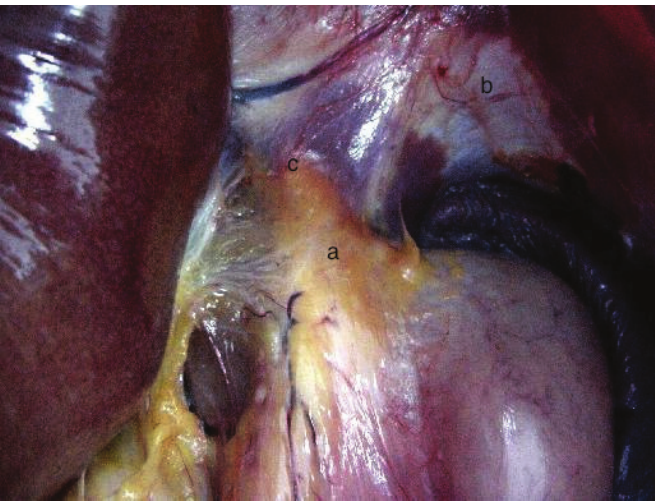
FIgURE 1 - conserved and usually seen geJ ( a ), diaphragm ( b ) and esophageal hiatus ( c